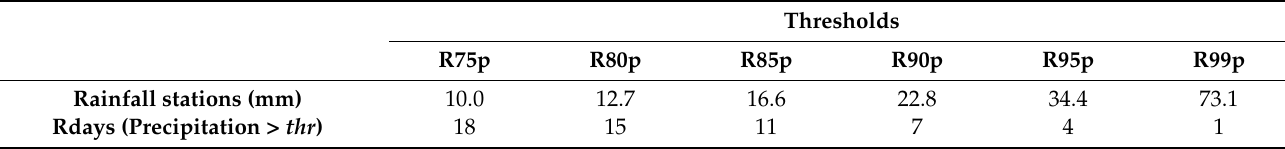
Table 3. Rainfall stations with different thresholds of precipitation and the numbers of days when- precipitation was > thr